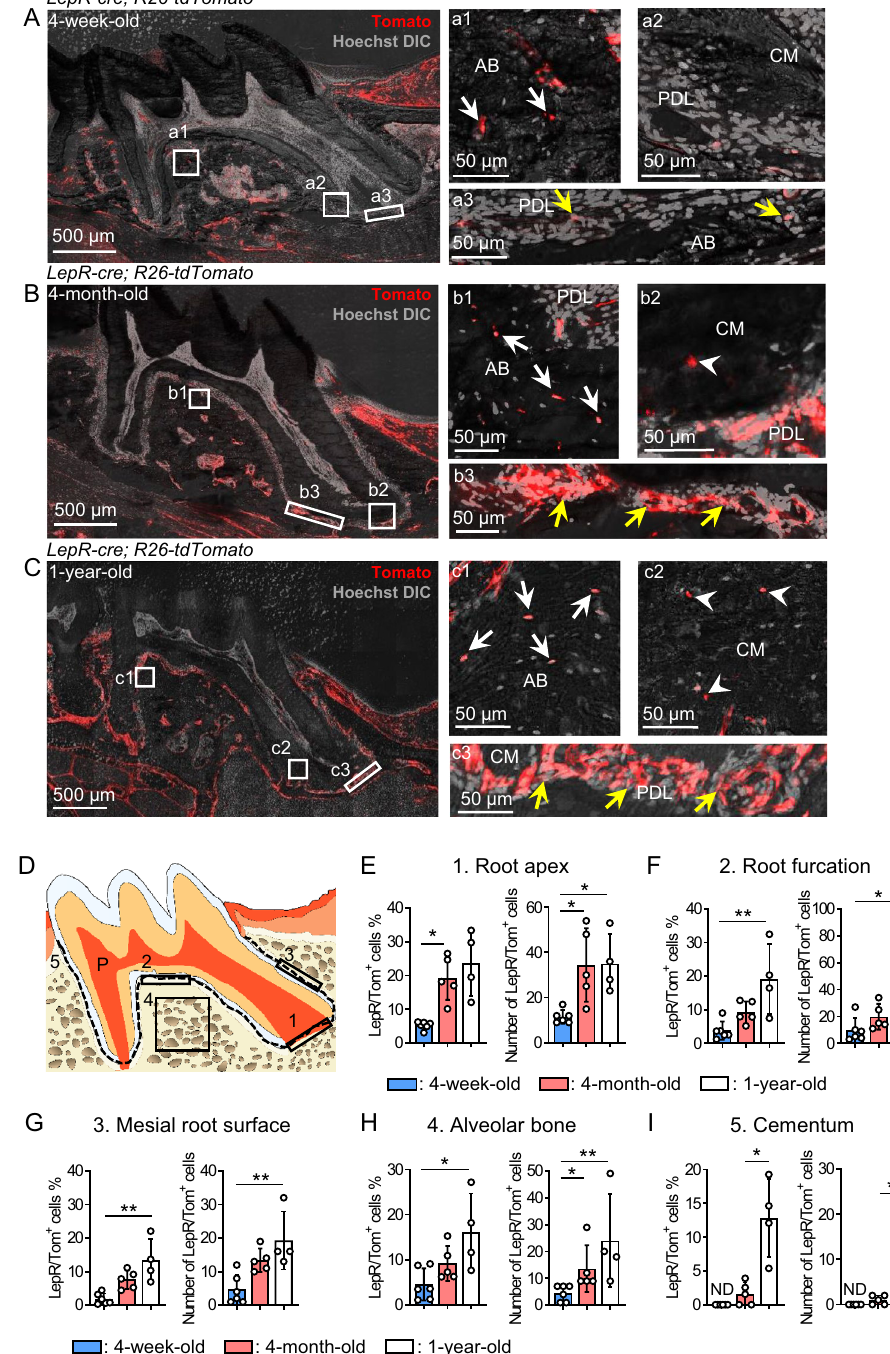
Figure 2. LepR/Tom + PDL cell subpopulation expands and contributes to the AB and cementum during aging. (A–I) Time-course analysis of LepR/Tom + cells around dental tissue. ( A–C ) Representative confocal images (Z stack) in thick maxillary first molar sections of 4-week- ( A , n = 6), 4-month- ( B , n = 5), and 1-year-old ( C , n = 4) LepR-cre ; R26-tdTomato mice; scale bar = 500 μm. Numbered panels represent the magnified views of the boxed areas; scale bar = 50 μm. White arrows: LepR/Tom + osteocytes, White arrowheads: LepR/Tom + cementcytes, yellow arrows: LepR/Tom + PDL cells. P: pulp, D: dentin, AB: alveolar bone, PDL: periodontal ligament, CM: cementum, BM: bone marrow, DIC: differential interference contrast. Nuclei were visualized using Hoechst. ( D–I ) Quantification of LepR/Tom + cells around dental tissue. ( D ) Quantification areas in dental tissue. 1: Root apex (0.05 mm 2 ), 2: Root furcation (0.05 mm 2 ), 3: Mesial root surface (0.05 mm 2 ), 4: Alveolar bone (0.25 mm 2 ), 5: The dotted line, the cementum between the mesial and distal cemento-enamel junction. ( E–I ) Frequency and absolute number of LepR/Tom + cells in the areas as shown in D at the indicated time point. ( E ) Root apex (left panel: Welch’s one-way ANOVA; right panel: One-way ANOVA followed by Tukey’s test). ( F ) Root furcation (left panel: One-way ANOVA followed by Tukey’s test; right panel: One-way ANOVA followed by Kruskal–Wallis test). ( G ) Mesial root surface (One-way ANOVA followed by Tukey’s test). ( H ) Alveolar bone (left panel: One-way ANOVA followed by Tukey’s test; right panel: One-way ANOVA followed by Kruskal–Wallis test). ( I ) Cementum (Two-tailed Welch’s t -test between 4-week- and 4-month-old mice); n = 4–6. * p < 0.05, ** p < 0.01. NS: not significant. Data are represented as mean ± standard deviation